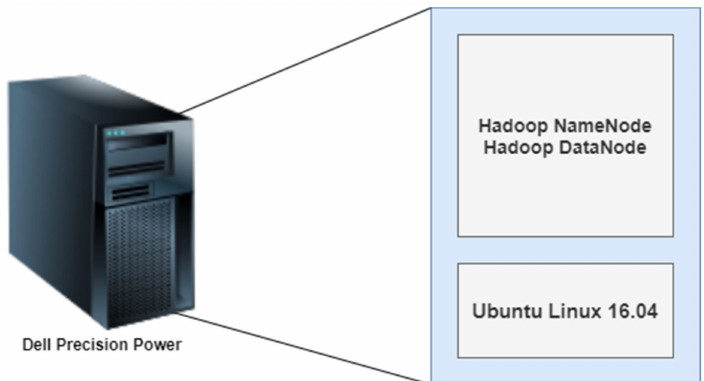
Figure 6. Single machine cluster